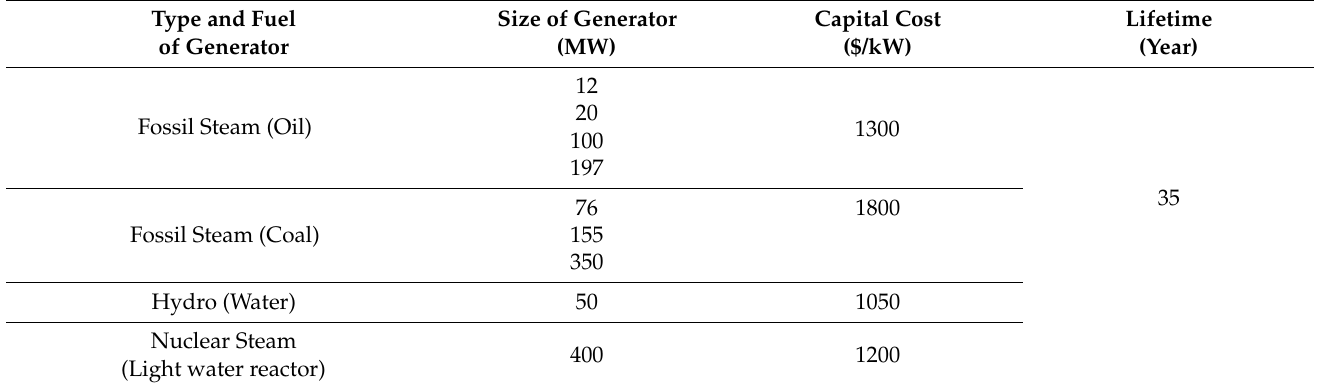
Table 4. Necessary values for calculating the degradation cost of generators